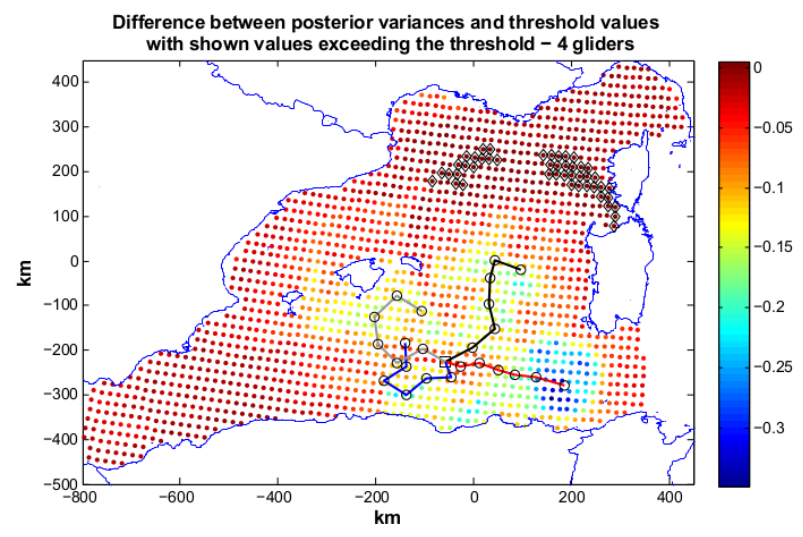
Figure 7. Scenario 2: planned paths for four gliders. The solution is characterized by J η = 0.22 and J c = 2.24. In the figure we also show the difference between posterior variances and relative values of the objective threshold. The solution almost reaches the mission target. More gliders are needed to reach the mission objective.